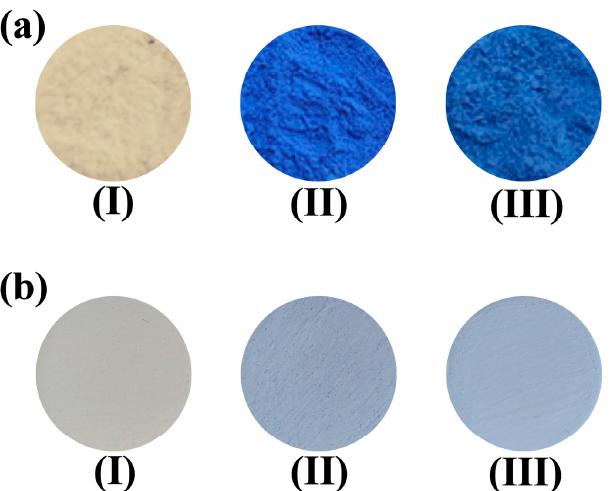
Figure 1. Photographs of the ZnAl 2 O 4 :M (M = Co 2+ and Co 2+ /Nd 3+ ) synthesized pigments: ( a ) in powder form and ( b ) dispersed in commercial white paint. The respective pigments were denoted: as (I) ZnAl 2 O 4 ; (II) Co-Gahnite; and (III) CoNd-Gahnite.